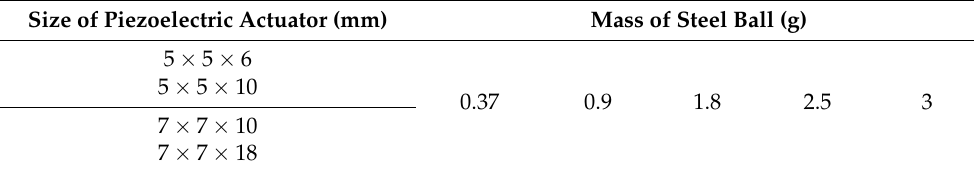
Table 5. Parameter table for the third set of